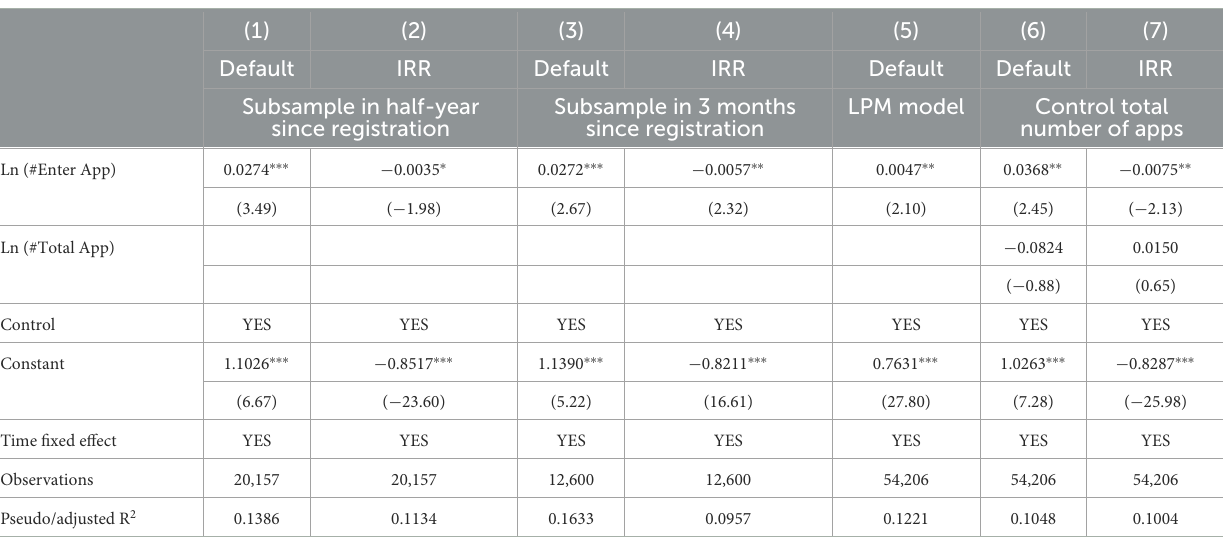
TABLE 8 Robustness